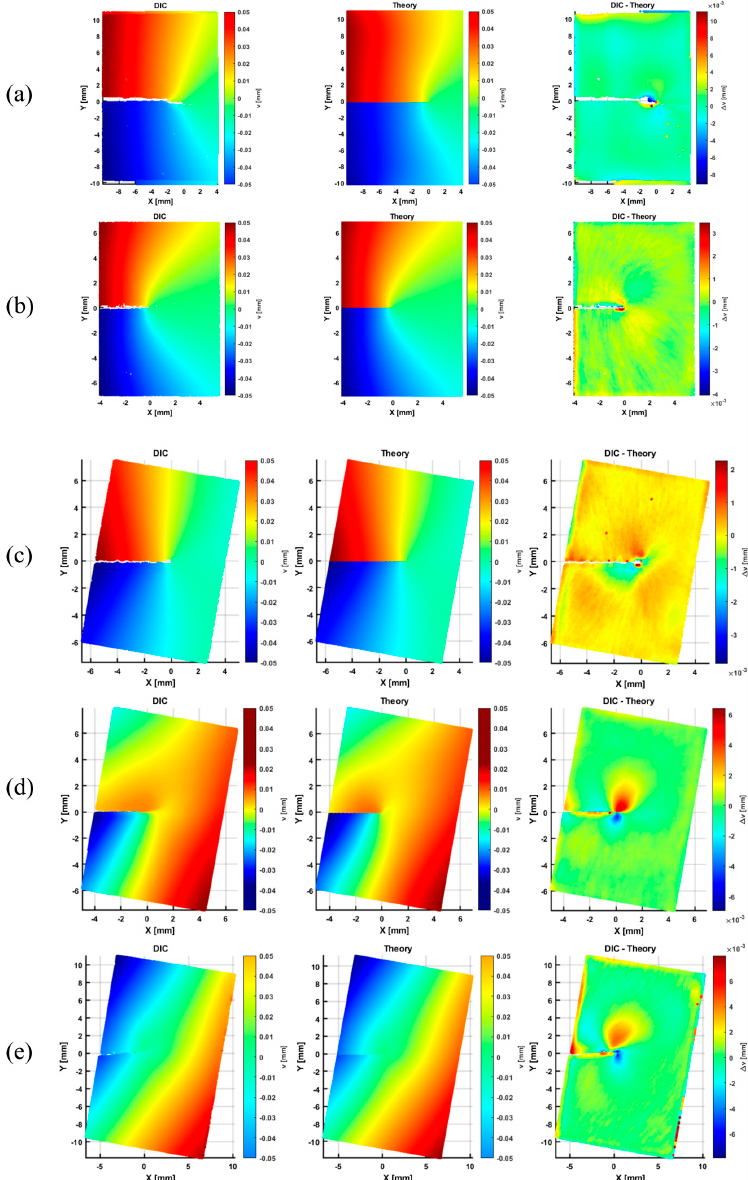
Figure 6. Comparison between the v -displacements field measured by the DIC and the one fitted by the Williams’ model for various specimens and loading condition: ( a ) SM-0-42-42 (Mode I, pre-cracked); ( b ) AM-0-42-42 (Mode I); ( c ) AM-10-42-42 (mixed mode I-II); ( d ) AM-10-42-18 (mixed mode I-II); ( e ) AM-10-42-10.2 (Mode II). Metals 2020 , 10 , x FOR PEER REVIEW 10 of 14